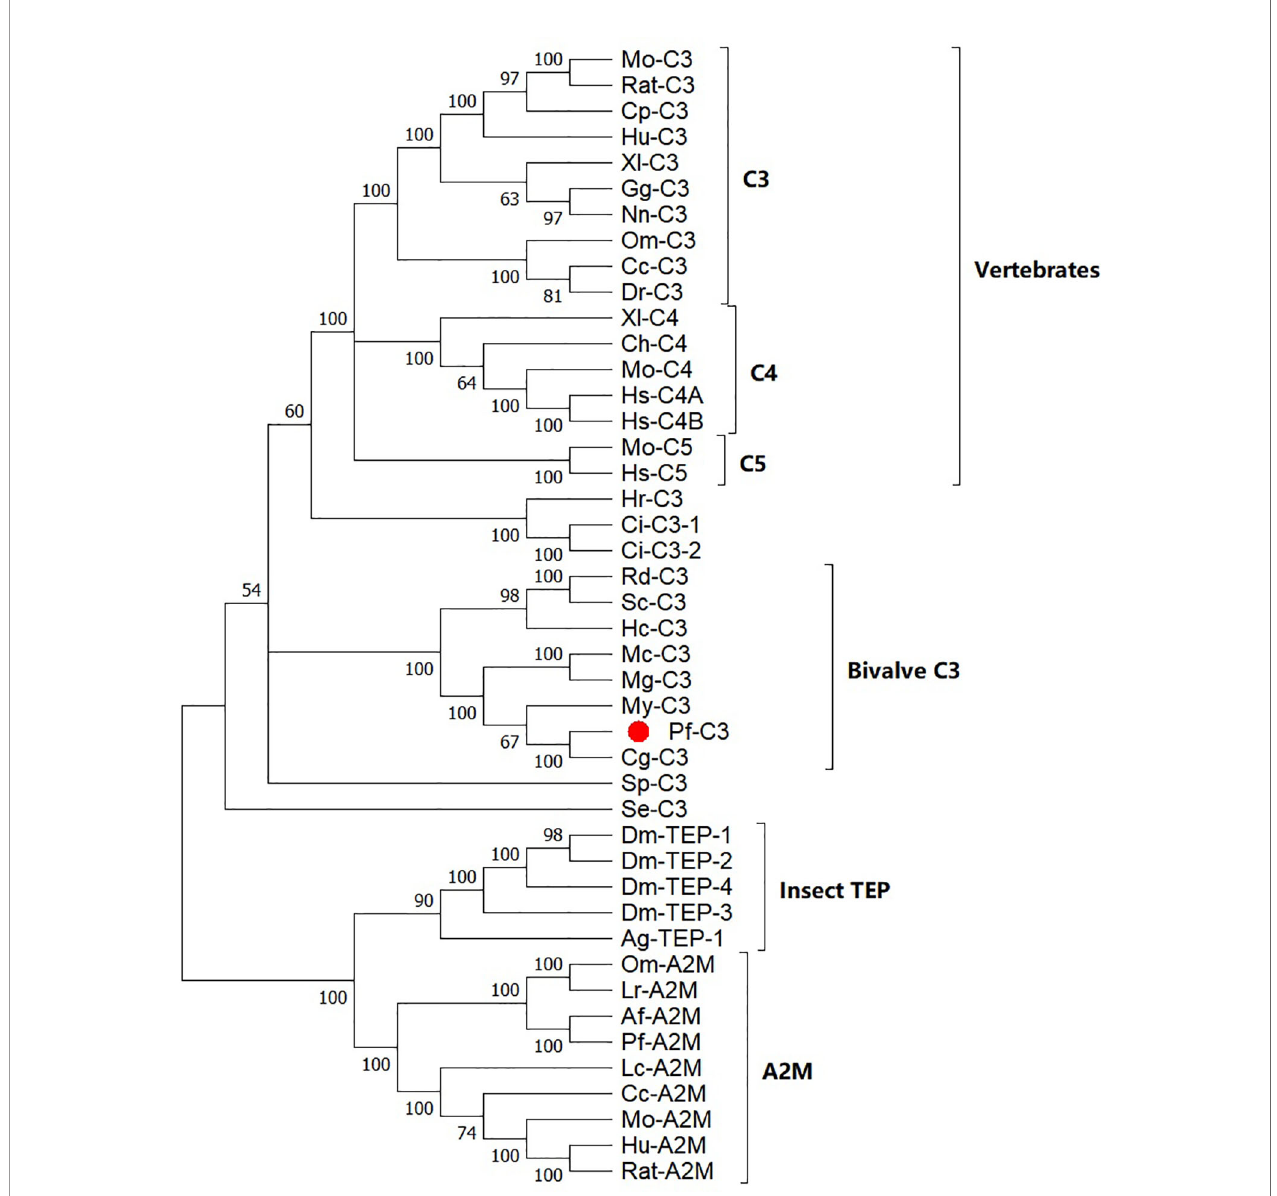
FIGURE 2 | Phylogenetic analysis of pf-C3 and other TEP family proteins with the Maximum Likelihood method. Sequences used to construct phylogenetic tree with the abbreviation and GenBank accession number are given below: Mo-C3, Mouse C3 (P01027.3); RatC3, Rat C3 (X52477.1); Cp-C3, Cavia porcellus C3 (P12387.2); Hu-C3, Human C3 (P01024.2); Xl-C3: Xenopus laevis C3 (AAB60608.1); Gg-C3, Gallus gallus C3 (Q90633); Nn-C3, Naja naja C3 (Q01833.1); DrC3, Danio rerio C3 (XP_696246.3); Om-C3, Oncorhynchus mykiss C3 (P98093.1); Cc-C3, Cyprinus carpio C3 (AB016210.1); Mo-C5, Mouse C5 (P06684.2); Hs-C5, Human C5 (P01031.4); Ch-C4, Chicken C4 (T28153); Xl-C4, Xenopus laevis C4 (BAA11188.1); Mo-C4, Mouse C4 (P01029.3); Hs-C4A, Homo sapiens C4A (AAB59537.1); Hs-C4B, Homo sapiens C4B (AAA99717.1); Hr-C3, Halocynthia roretzi C3 (AB006964.1); Ci-C3-1, Ciona intestinalis C3 (Q8WPD8); Ci-C3-2, Ciona intestinalis C3 (Q8WPD7); Rd-C3, R. decussatus C3 (ACN37845); Sc-C3, Sinonovacula constricta C3 (ANI85912); Hc-C3, Hyriopsis cumingii C3 (MK648113); Mc- C3, Mytilus coruscus C3 (MG197986); Mg-C3, Mytilus galloprovincialis C3 (AJQ21542); My-C3, Mizuhopecten yessoensis C3 (OWF37722); Cg-C3, C. gigas C3 (NP_001292308); Sp-C3, Strongylocentrotus purpuratus C3 (NP_999686); Se-C3, Swiftia exserta C3 (AAN86548); Dm-TEP-1, Drosophila melanogaster TEP-1 (CAB87807.1); Dm-TEP-2, (CAB87808.1); Dm-TEP-4, D. melanogaster TEP-4 (CAB87810.1); Dm-TEP-3, D. melanogaster TEP-4 (CAB87809.1);